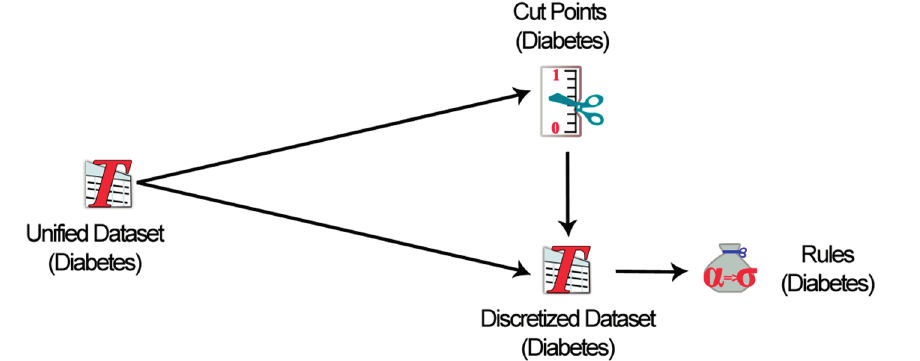
Figure 6. Rules creation process from the unified diabetes dataset using rough set-based algorithm ( LEM2 ).